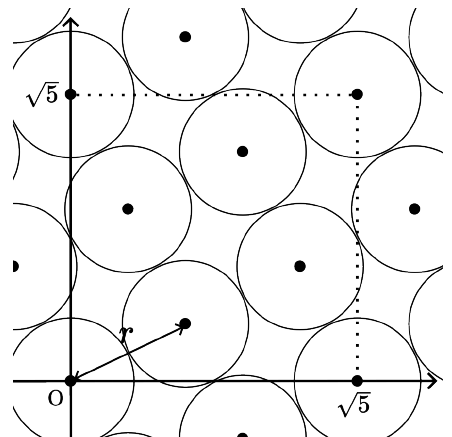
generated by (¯2 , ¯1) T and circles with radius r/ 2 5